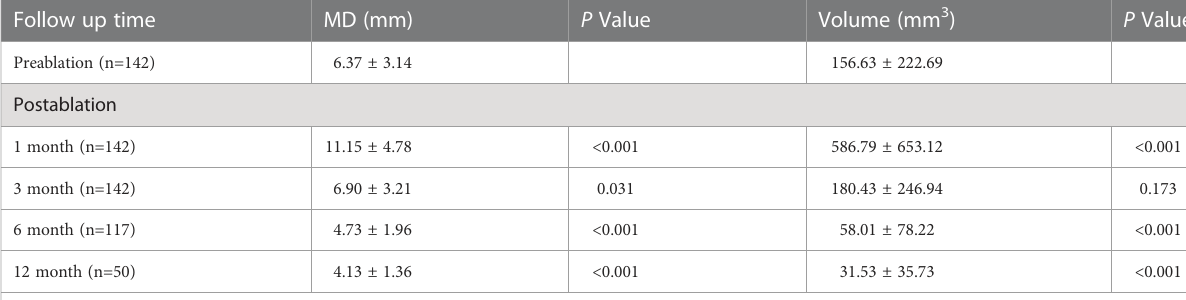
TABLE 2 The changes of mean maximal diameter and volume after ablation over 1 year.